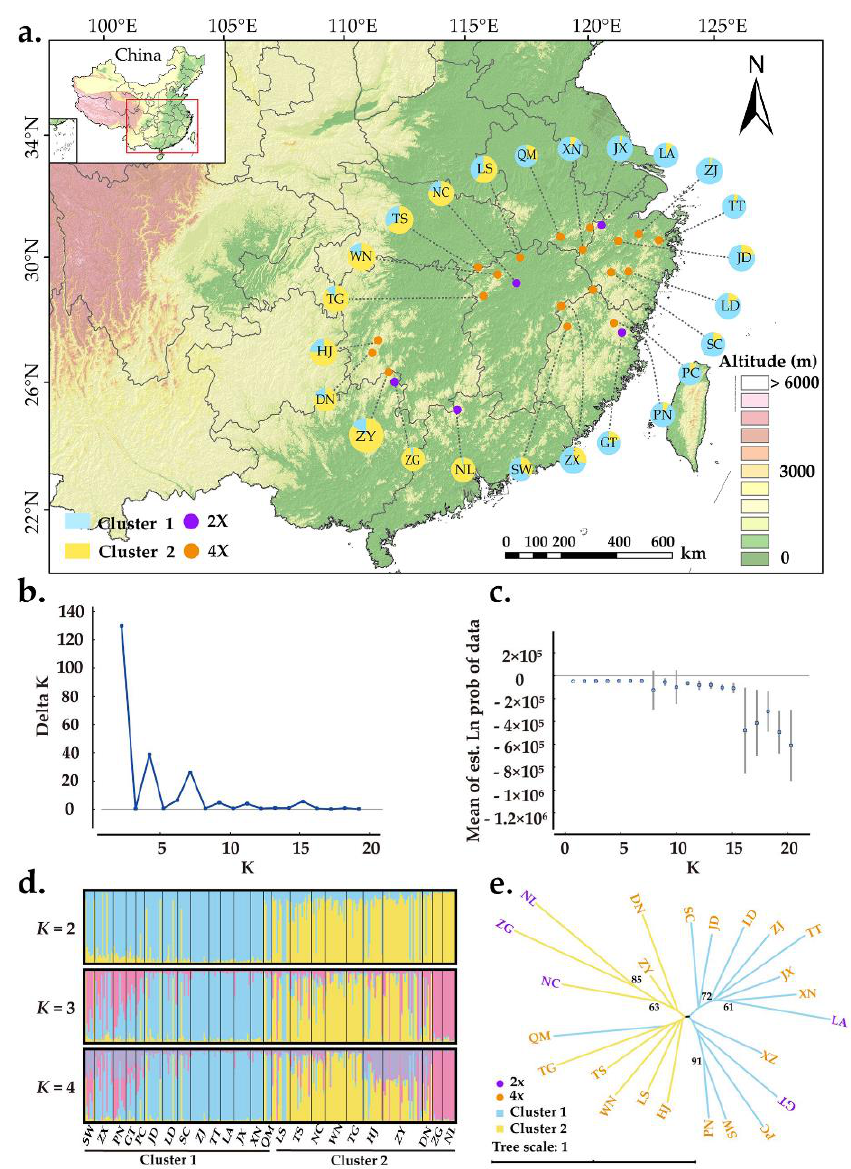
Figure 3. Population genetic structure of A. chinensis . ( a ) Geographic distribution of the 24 popula- tions. Each population is color-coded in different clusters according to the results of STRUCTURE analysis. The purple and orange dots represent diploid and tetraploid populations, respectively; ( b ) the ∆ K values are presented for K = 1–20; ( c ) the likelihood L( K ) values presented for K = 1–20; ( d ) histogram of the Bayesian assignment for 263 individuals in 24 populations of A. chinensis . STRUC- TURE plots are presented for K = 2 to K = 4, respectively. Each vertical bar represents one individual and the capital letters on the abscissa represent different populations; ( e ) neighbor-joining tree based on genetic distances for 24 natural populations of A. chinensis. The robustness of each node was evaluated by 1000 bootstrap replicate.